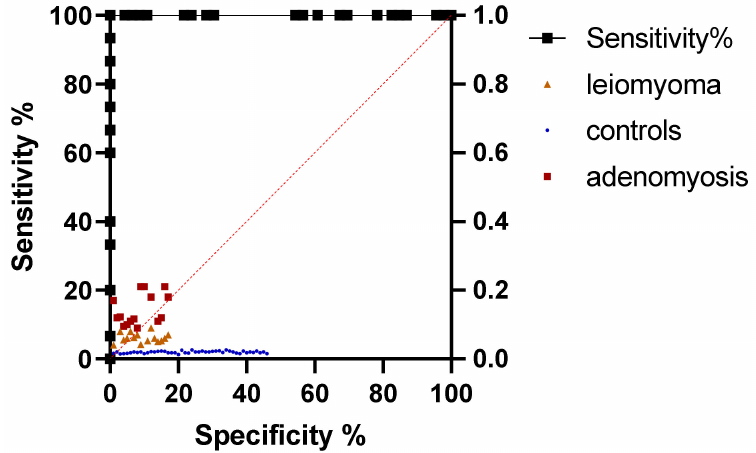
Figure 7. ROC curve of max SR values for differential diagnosis of adenomyosis and leiomyoma from healthy uterine